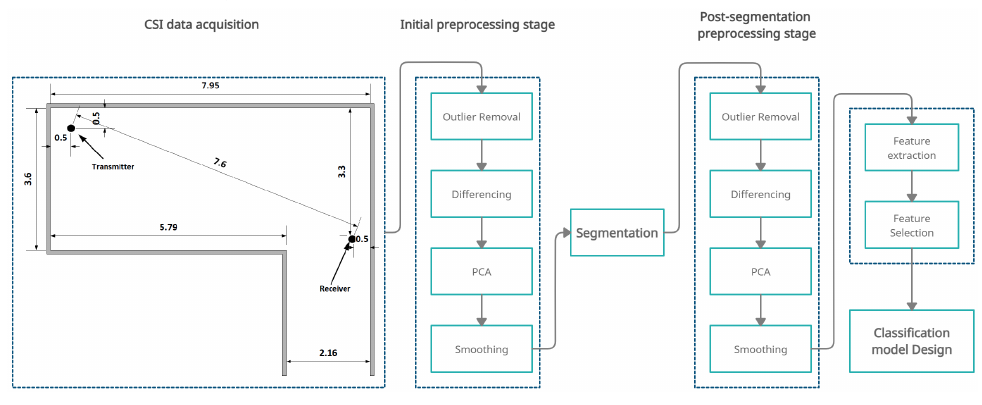
Figure 3. The structure of the proposed HAR